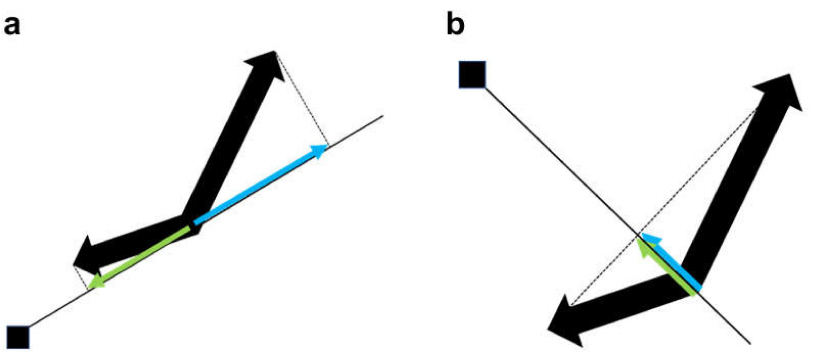
Figure 10. Projection of two current velocities in different beam directions. The squares represent the position of the radar station, the solid lines represent the beam direction, the black arrows represent two currents with different directions and speeds, and the blue and green arrows represent the projected radial velocity of the current along the beam directions. ( a ) The display in which two currents can be recognized as different currents with radial velocities. ( b ) The display in which two currents can be recognized as the same current with radial